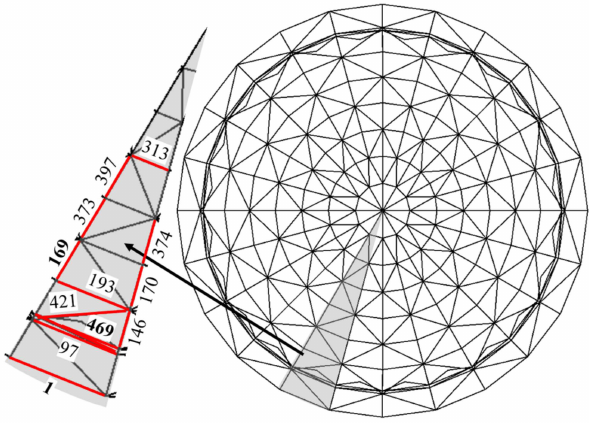
Figure 8. The monitored area and the location of important members.